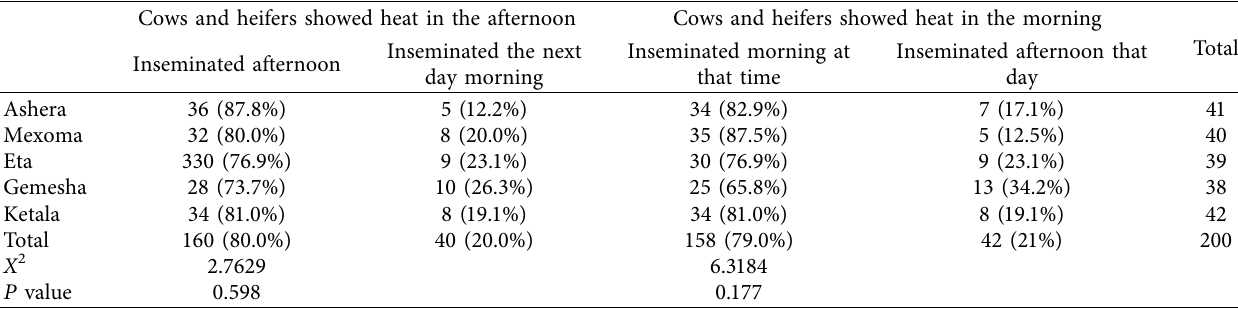
Table 3: Attitude of respondents towards the insemination time in the estrous cycle of their cattle. Cows and heifers showed heat in the afternoon